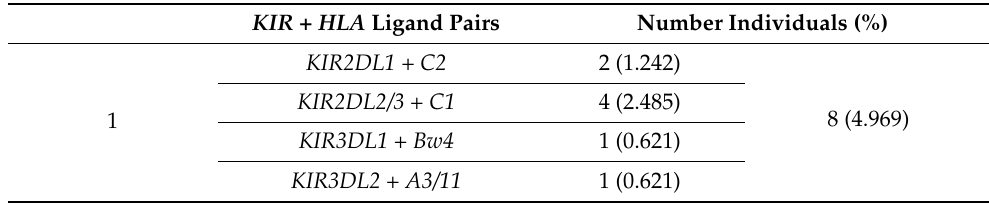
Table 4. Inhibitory KIR and HLA ligand